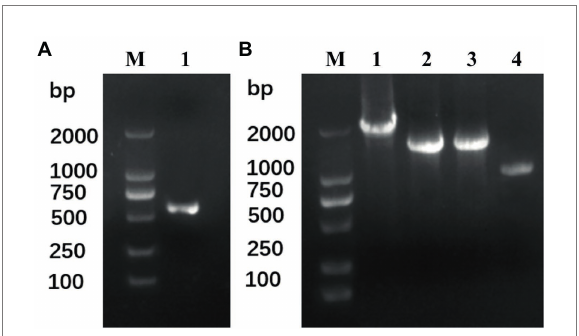
FIGURE 3 Amplification of the THF-dependent demethylase gene from the total DNA of the enriched consortium. (A) Fragment amplification from the total DNA of the enriched consortium using degenerate primers, Line M: DNA marker, line 1 amplified product using primer pair dF1 and dR1. (B) Amplified products from the upstream and downstream of the acquired fragment by SEFA- PCR, Line M: DNA marker, line 1: the first round SEFA-PCR from the fragment upstream, line 2: the first round SEFA-PCR from the fragment downstream, line 3: the second round SEFA-PCR from the fragment upstream, line 4: the second round SEFA-PCR from the fragment downstream.